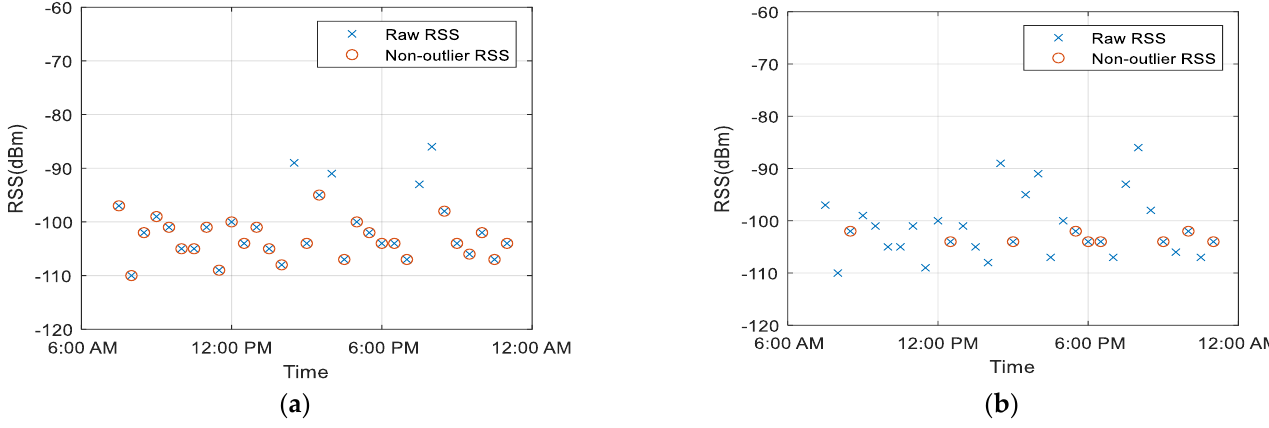
Figure 3. RSS outlier detection comparison for RSS Dataset 1. ( a ) 𝑆 𝑛 scale estimator, and ( b ) MAD scale estimator.